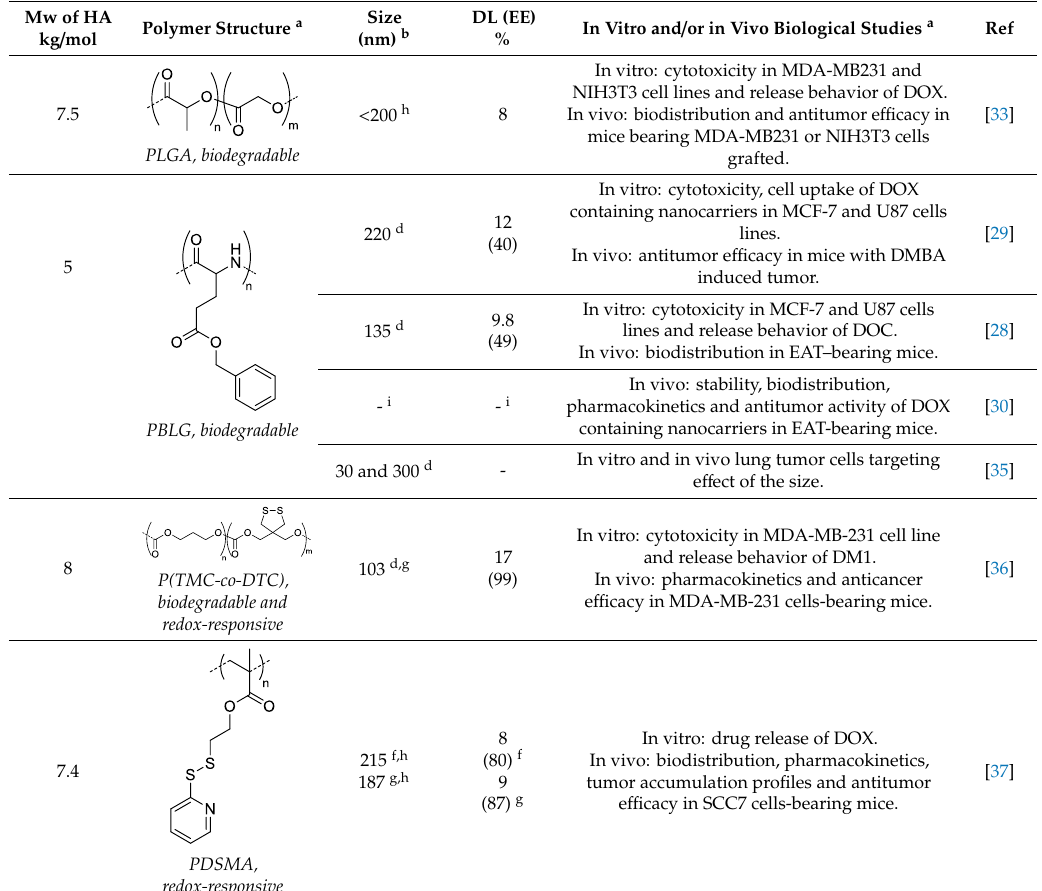
a abbreviations: PLC: poly(caprolactone), PLGA: poly(lactide-co-glycolide), PBLG: poly(benzyl- L - glutamate), P(TMC-co-DTC): poly(trimethylene carbonate-co-dithiolane trimethylene